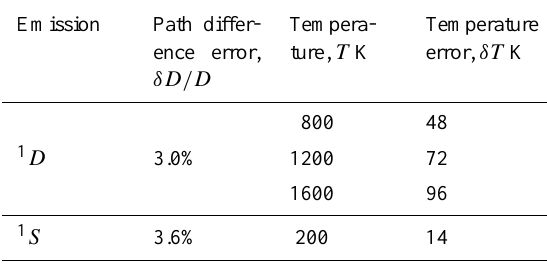
Table A1. Interferometric Parameters for O 1 D and O 1 S Parameter